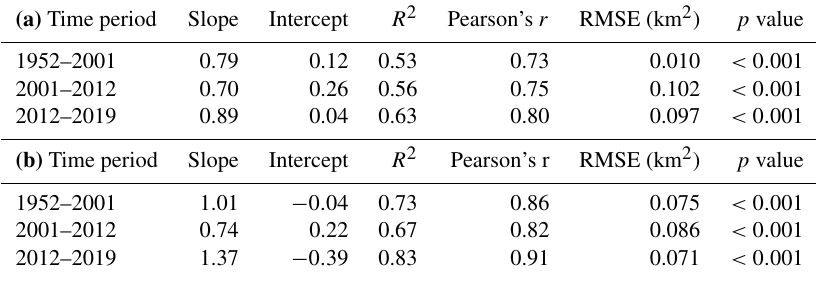
Table 2. Linear regression parameters and correlation metrics for each period (a) using GSB transformed data and (b) using the SAFRAN reanalysis product.